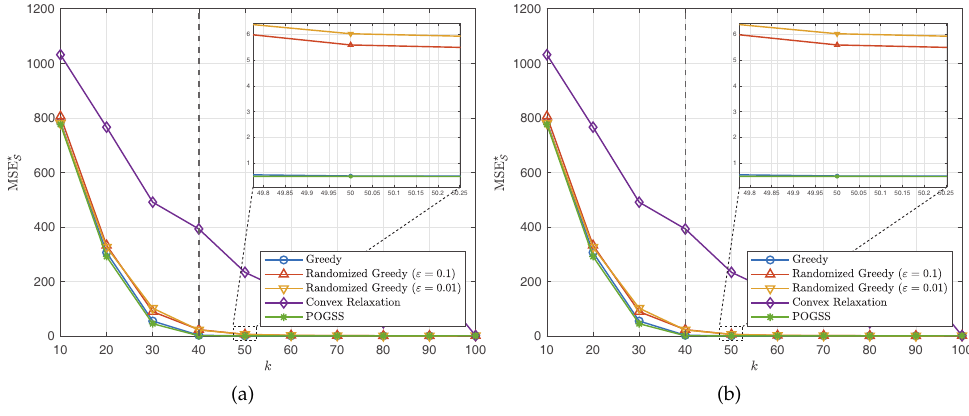
Figure 3. Results for bandlimited graph signals obtained on Gaussian graphs. ( a ) MSE (cid:63) S v.s. k . ( b ) Convergence curve when k = 20.